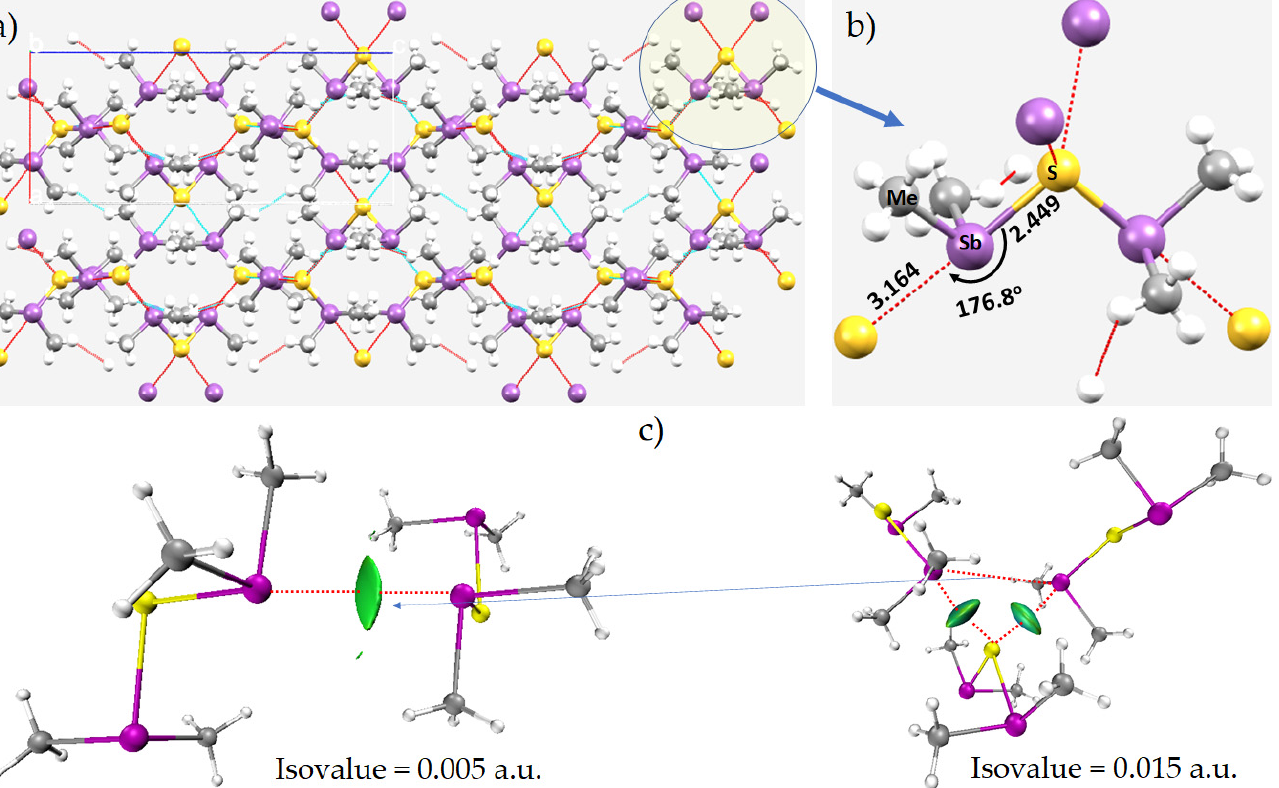
Figure 14. ( a ) The ball-and-stick model of the 2 × 2 supercell structure of crystalline ((CH 3 ) 2 Sb) 2 S (CSD ref. code MELNEW). ( b ) The local topology of Sb ··· S pnictogen bound interactions in the crystal. ( c ) The IGM- δ g isosurface plots between the ((CH 3 ) 2 Sb) 2 S molecular entities in the crystal, illustrating Sb ··· Sb and Sb ··· S interactions. Bond lengths and bond angles are in Å and degree, respectively. Contacts between atoms are shown as dotted lines in red or cyan. Selected atoms are labelled in ( b ).